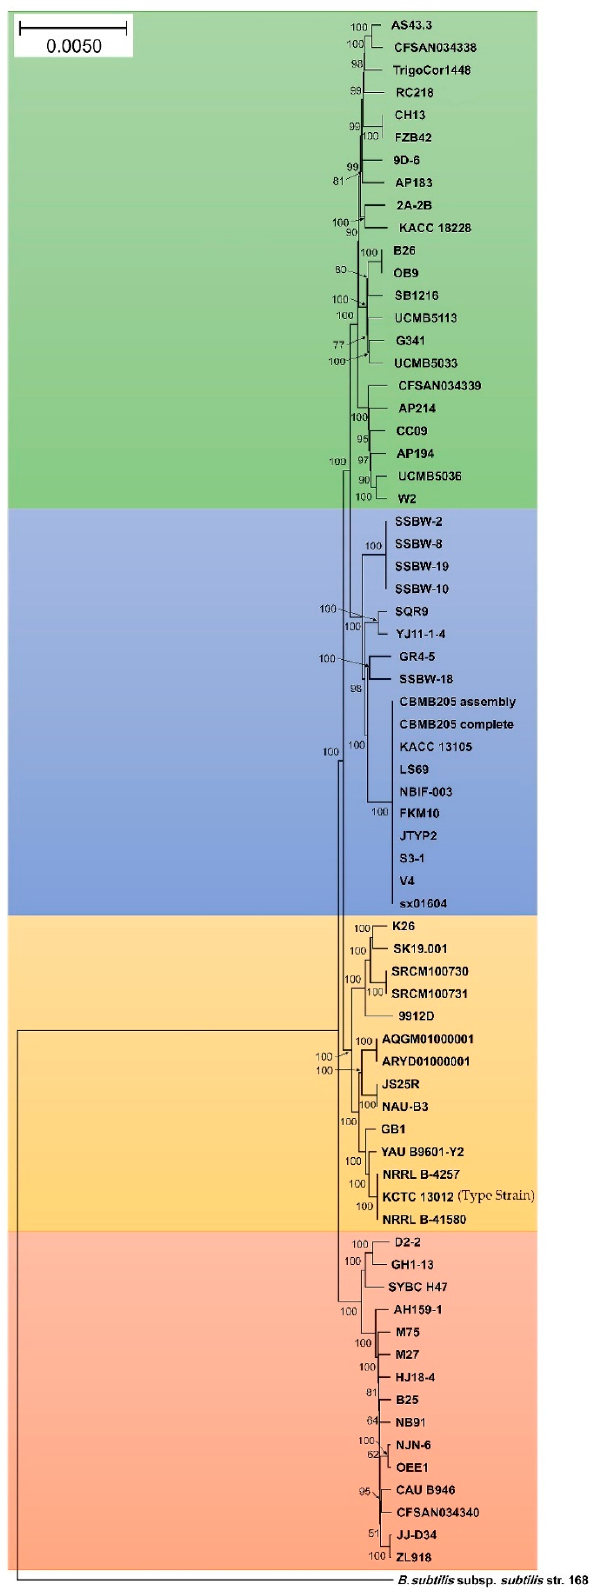
Figure 3. Neighbour-joining phylogenomic tree of Gram-positive bacteria Bacillus velezensis isolates. Bacillus subtilis subsp. subtilis isolate 168 was used as the outgroup. Supports for branches were assessed by bootstrap resampling of the data set with 1,000 replications. Each colour corresponds to a “sister clade” that represent a putative new species.